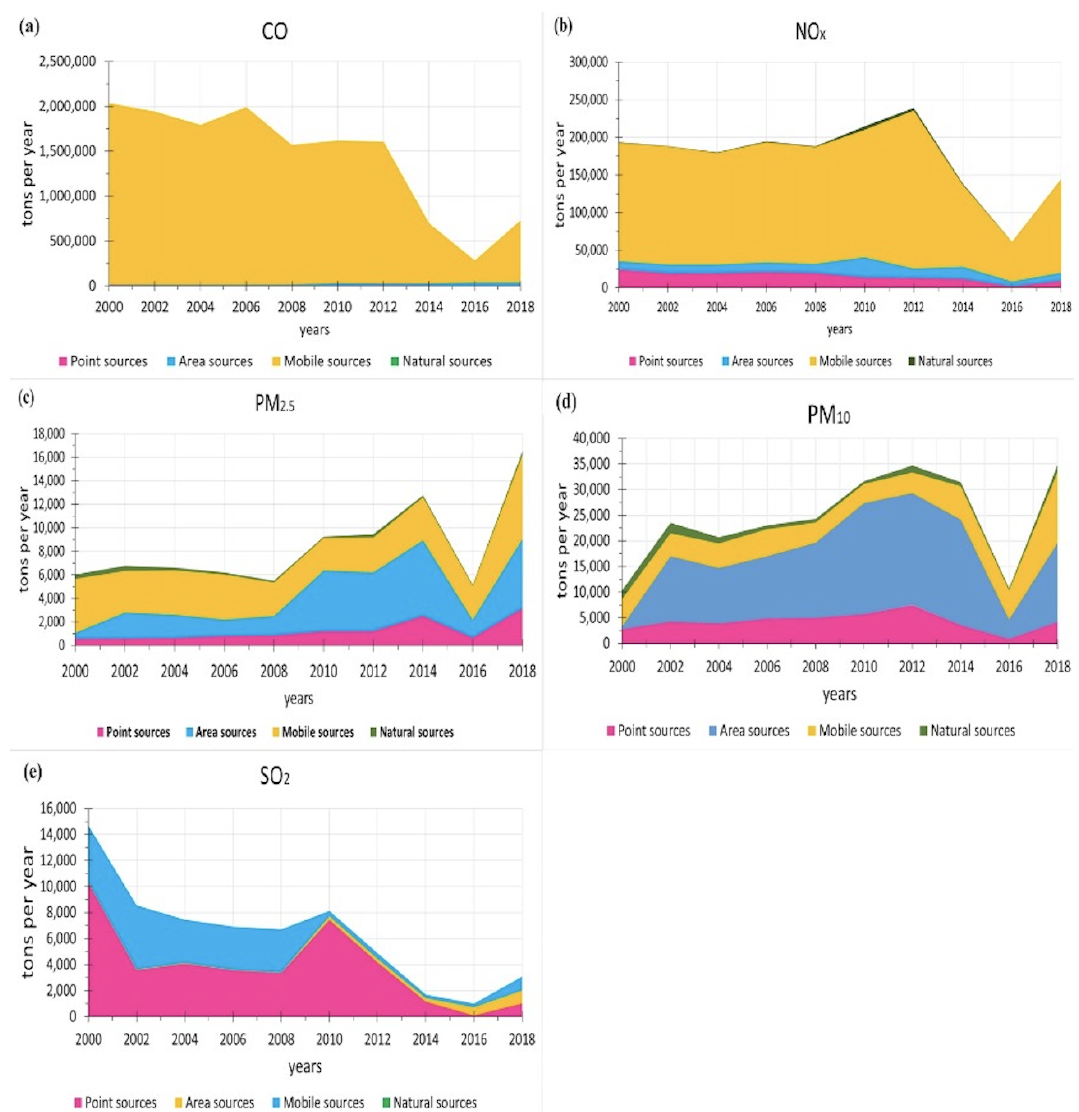
Figure 2. Time series of the emissions of ( a ) CO, ( b ) NO x , ( c ) PM 2.5 , ( d ) PM 10 , and ( e ) SO 2 from 2000 to 2018, obtained from the official MCMA emissions